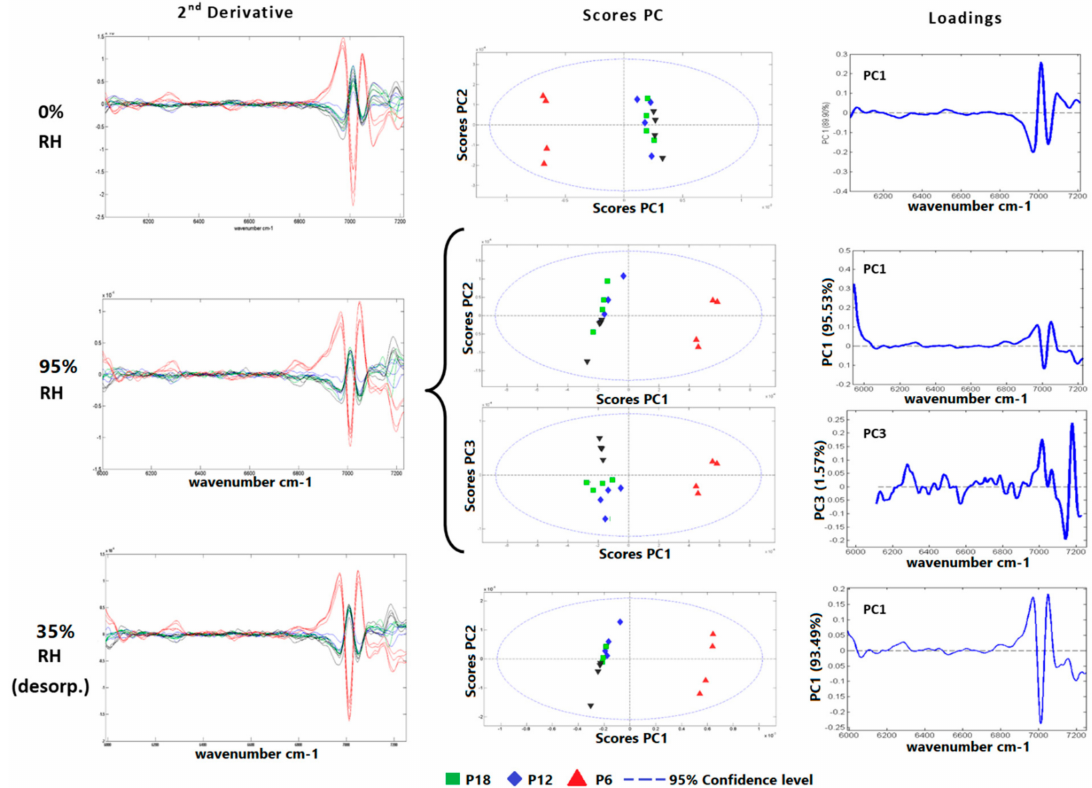
Figure 5. Plots of the second derivative spectra, scores, and loadings in the range of 7200 to 6000 cm − 1 at 0% RH, 95% RH, and 35% RH desorption. (PC = Principal Component).